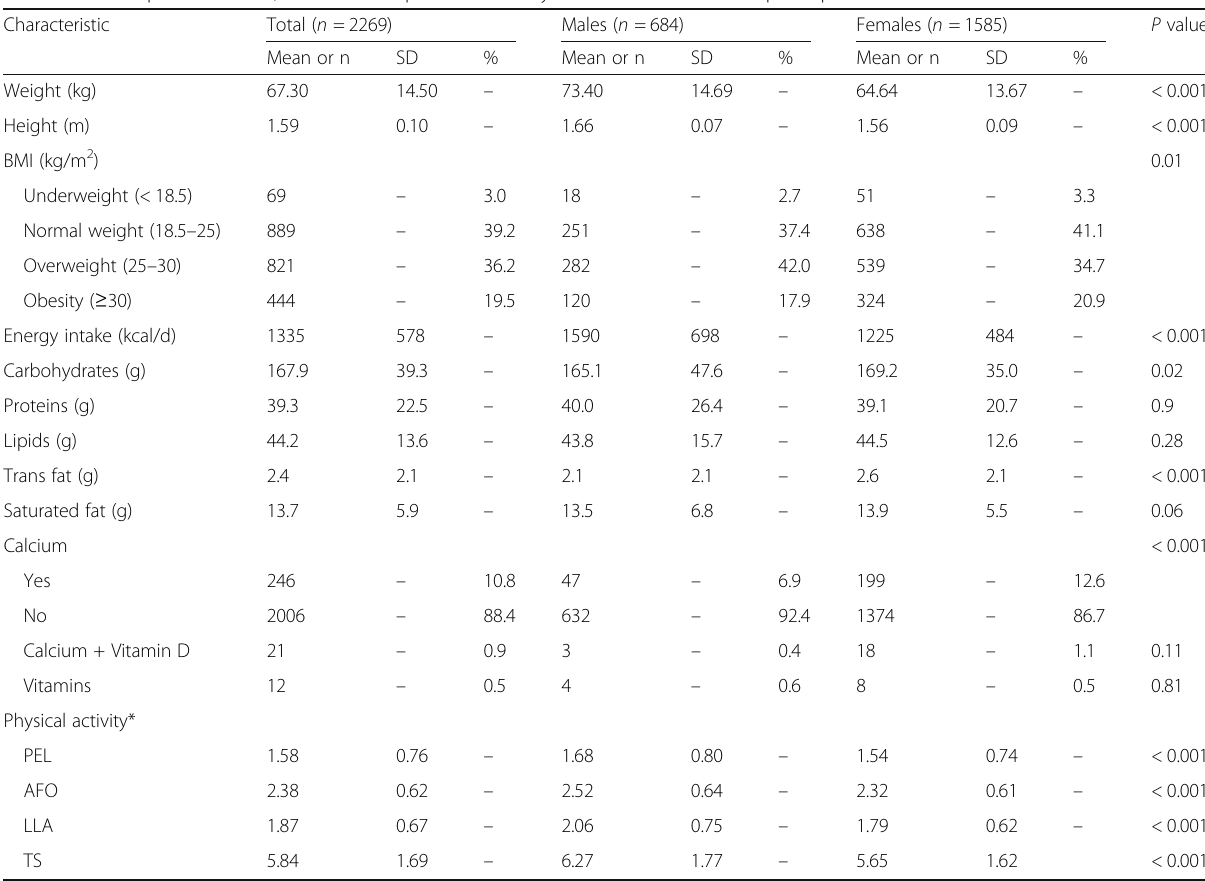
Table 2 Anthropometric data, food consumption and lifestyle characteristics of the